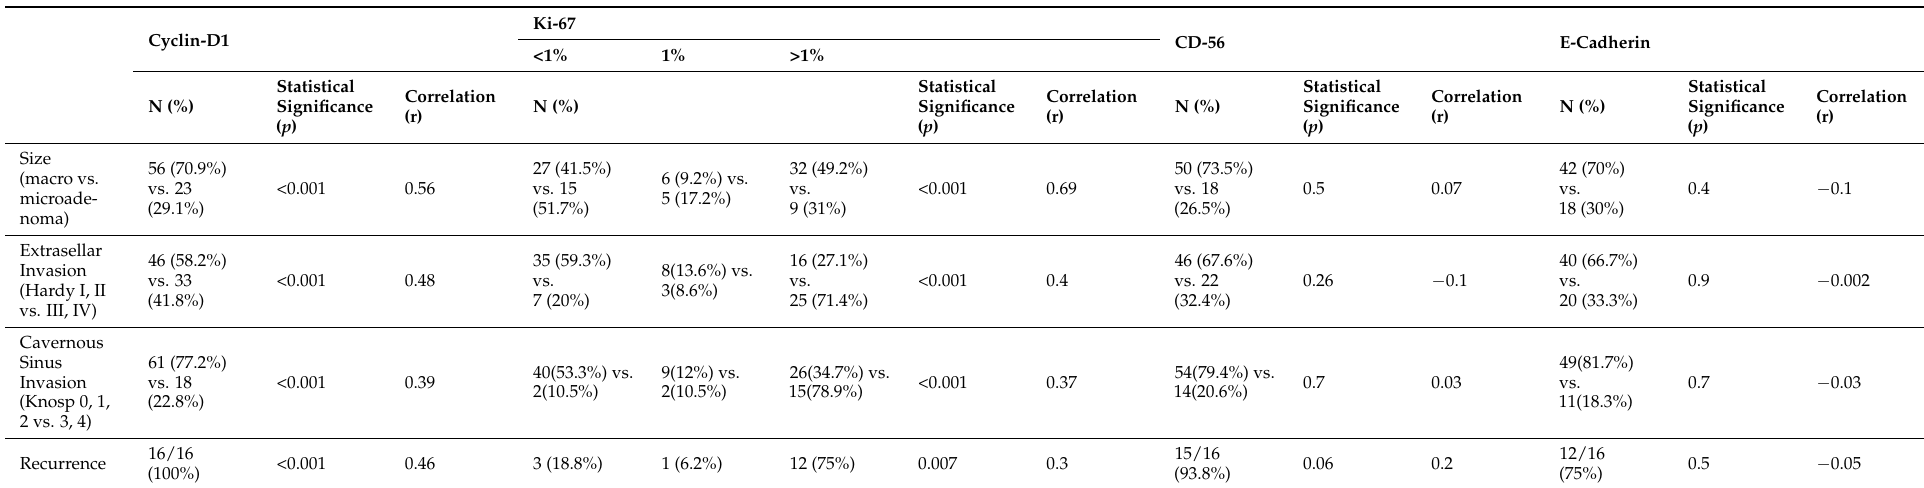
Table 2. Expression of Cyclin-D1, Ki-67, CD-56, E-Cadherin (NFPAs and